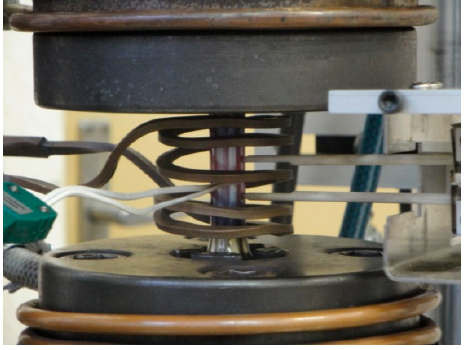
Figure 4. Testing station for low-cycle fatigue tests at 650 °C.